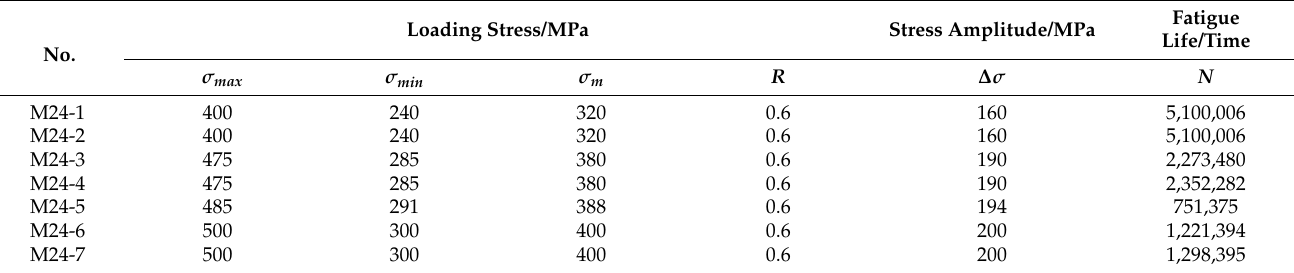
Table 5. Constant amplitude fatigue test results of M24 torsional shear-type high-strength bolt with pretension ( σ max = 400–500 MP).